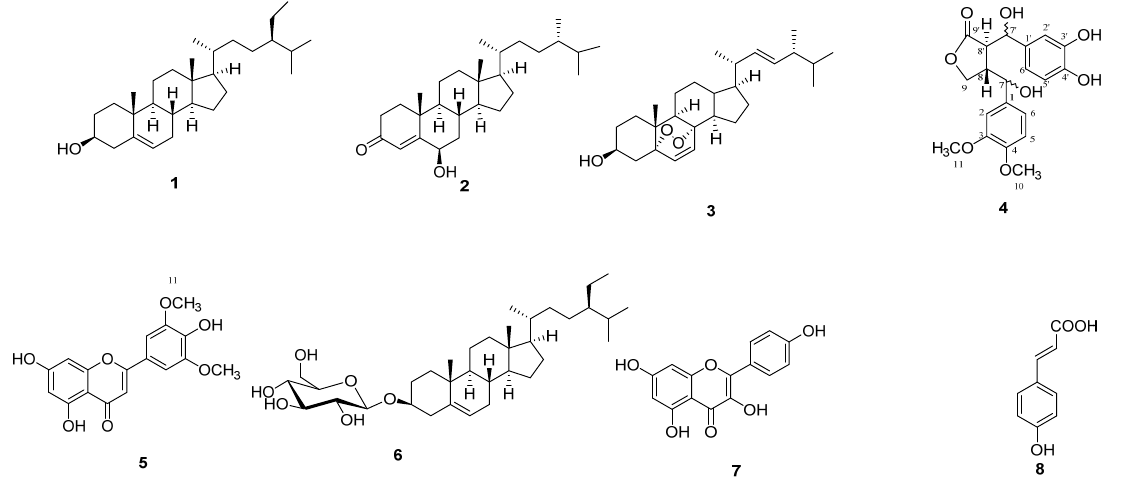
Figure 1. Chemical structures of isolated